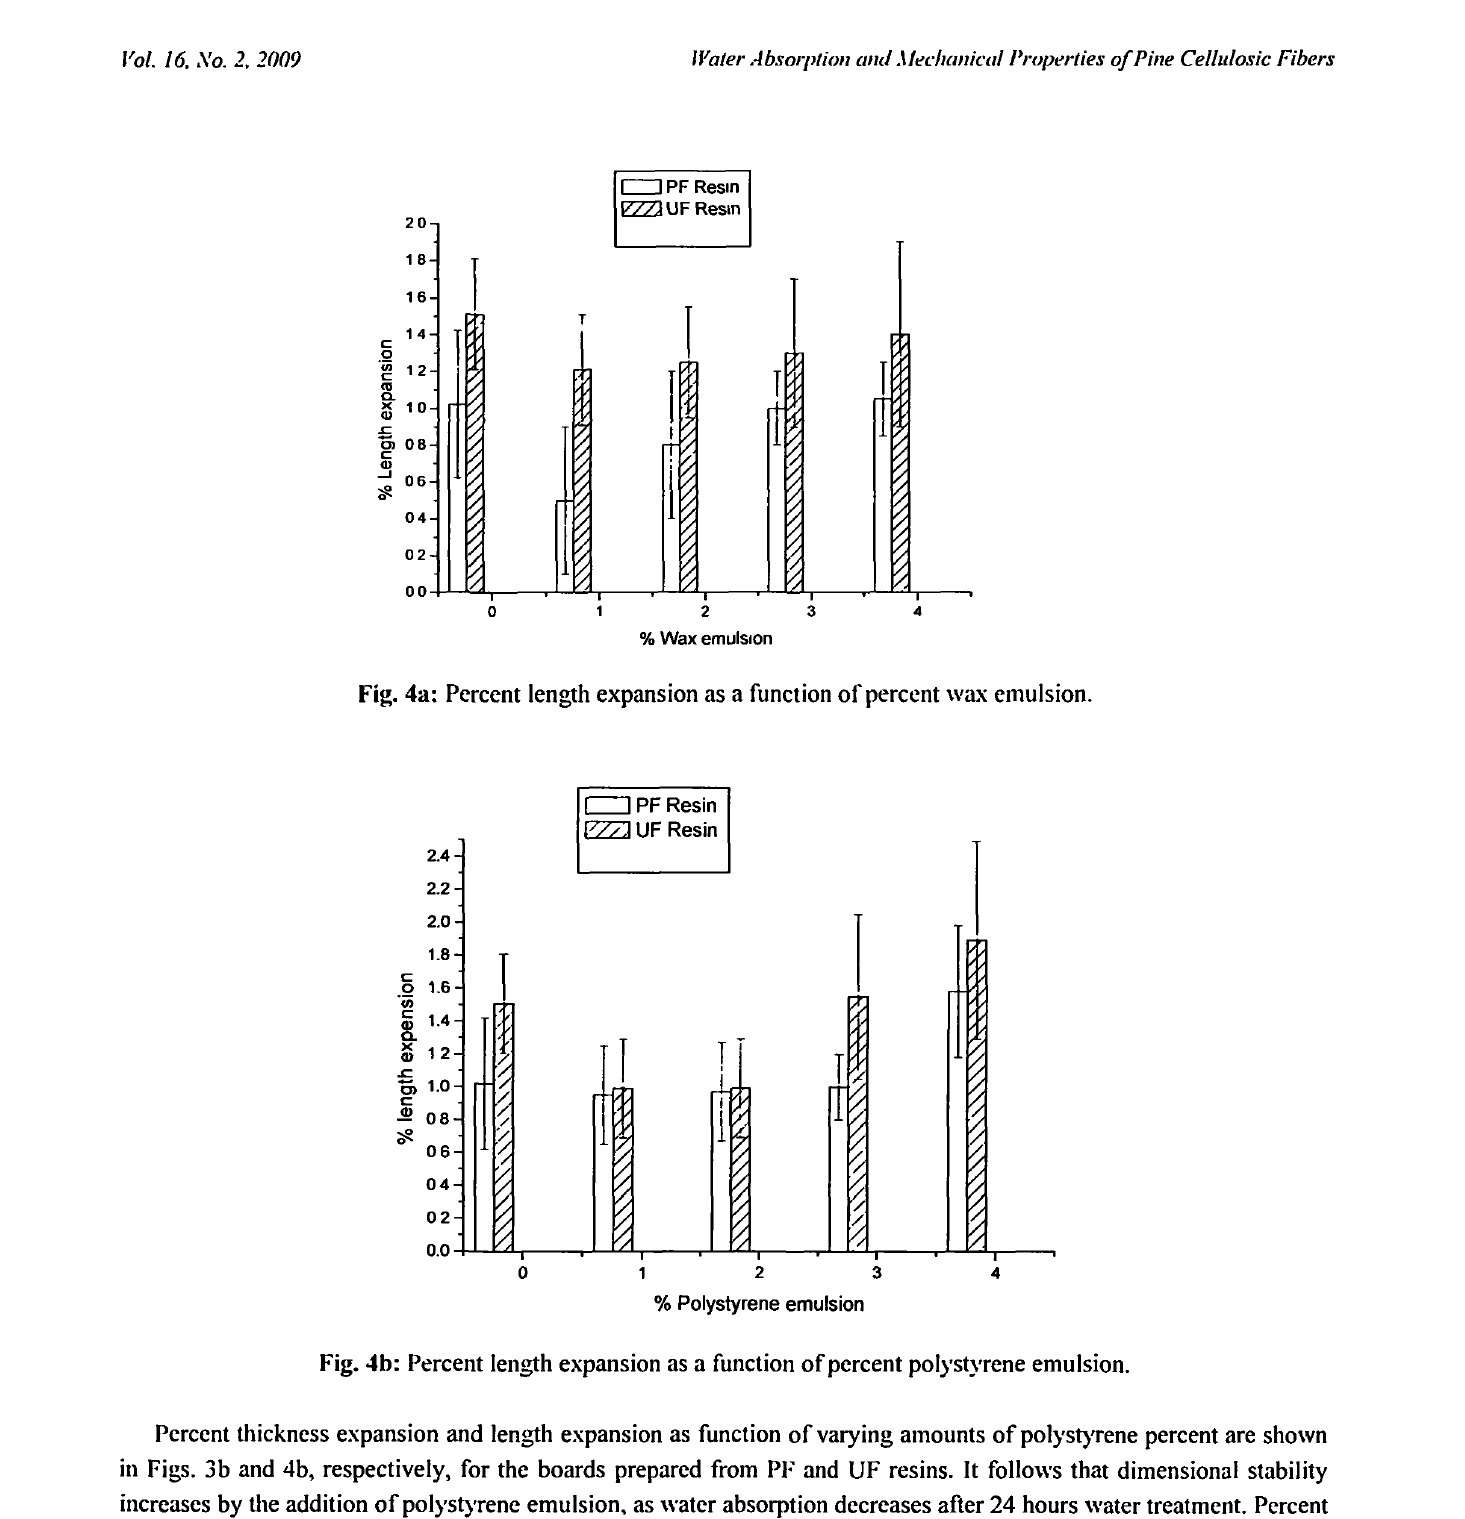
Fig. 4a: Percent length expansion as a function of percent wax emulsion.